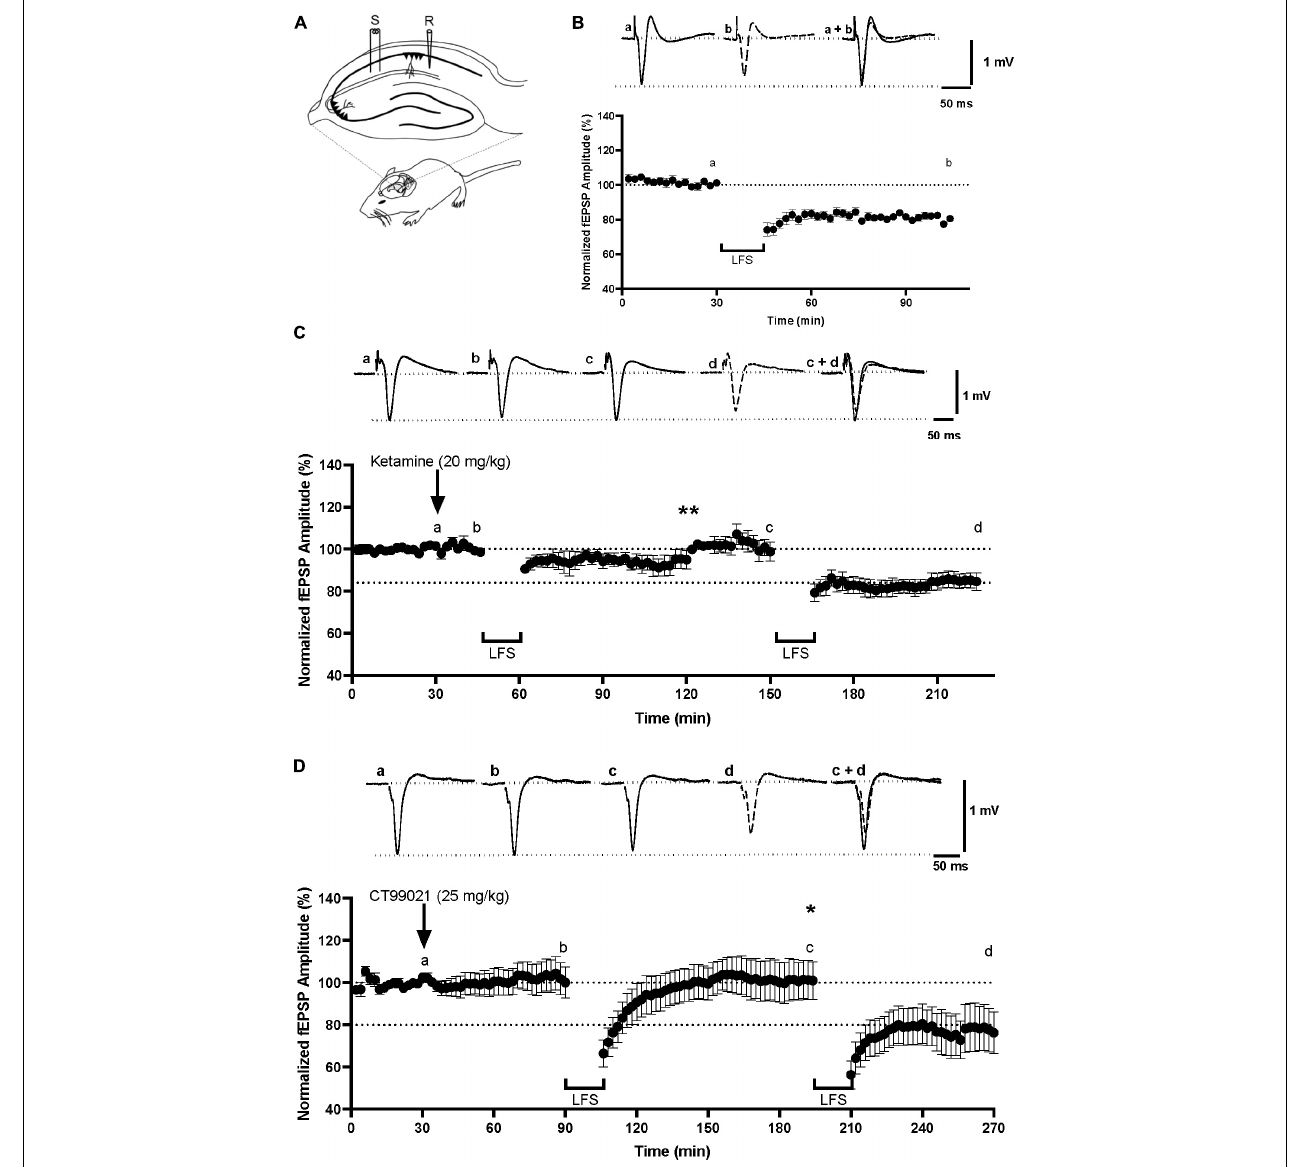
FIGURE 1 | CT99021 reversibly blocks the induction of NMDAR-LTD at CA1 synapses in vivo . (A) Schematic drawing of electrode placements in anesthetized adult mice (S: stimulating electrode, R: recording electrode). (B) NMDAR-LTD in anesthetized mice using LFS ( n = 7). (C) Ketamine, 20 mg/kg (i.p.), blocks the induction of LTD (** p < 0.01, one-way ANOVA) in a reversible manner ( n = 4). (D) CT99021, 25 mg/kg (i.p.), blocks NMDAR-LTD (* p < 0.05, one-way ANOVA) in a reversible manner ( n = 3). The inserts are averages of four successive traces taken from the experiments at the time indicated on the plots. Data are presented as mean ±